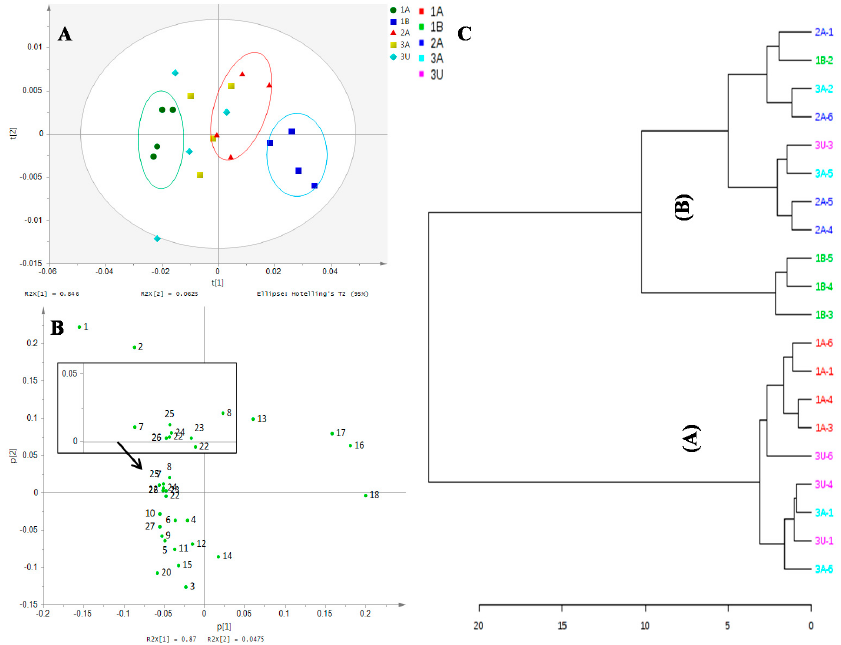
Figure 2. ( A ) The PCA score plot; ( B ) loading score plot; where; 1, beta glucose; 2, alpha